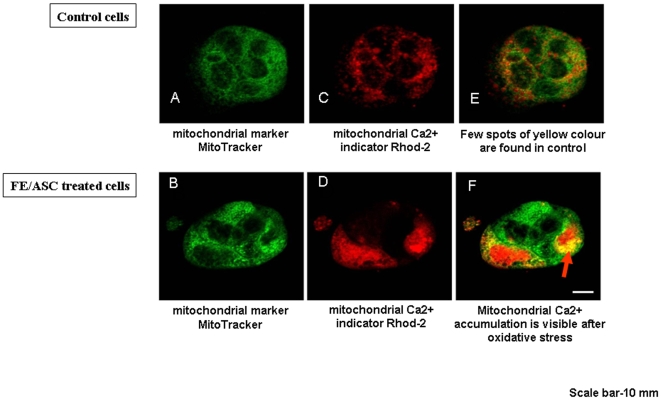
Influence of oxidative stress on mitochondrial calcium homeostasis in Caco-2/15 cells.Representative fluorescence images of control and FE/ASC-treated Caco-2/15 cells loaded with the mitochondrial dye MitoTracker™ (A, B) and the mitochondrial Ca2+ indicator Rhod-2 (C, D). Merged images (E, F) indicate colocalization of the two dyes in the mitochondria. Mitochondrial Ca2+ accumulation is visible upon oxidative stress (arrow). Scale bar-10 µm.